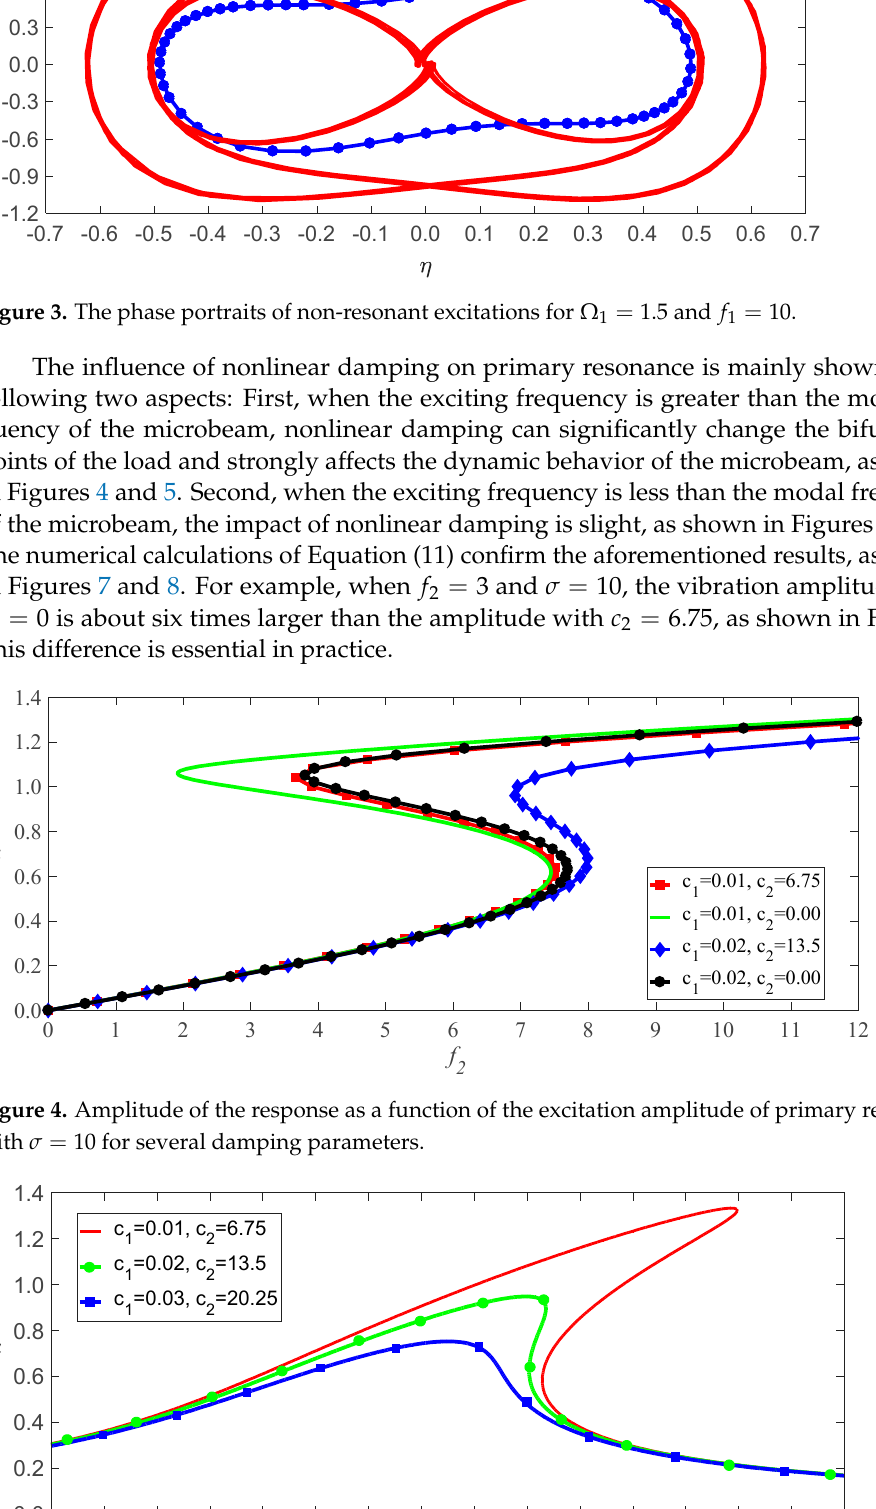
Figure 5. Frequency-response curves of primary resonance for f 2 =